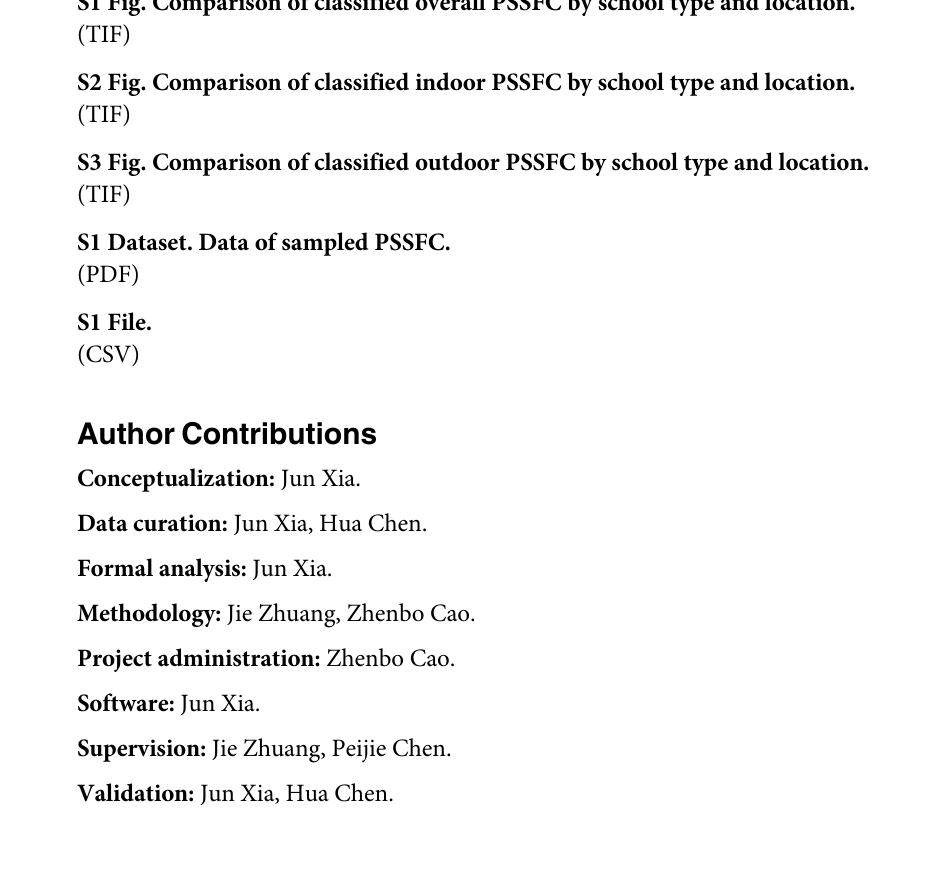
S1 Fig. Comparison of classified overall PSSFC by school type and location. S2 Fig. Comparison of classified indoor PSSFC by school type and location. S3 Fig. Comparison of classified outdoor PSSFC by school type and location. S1 Dataset. Data of sampled